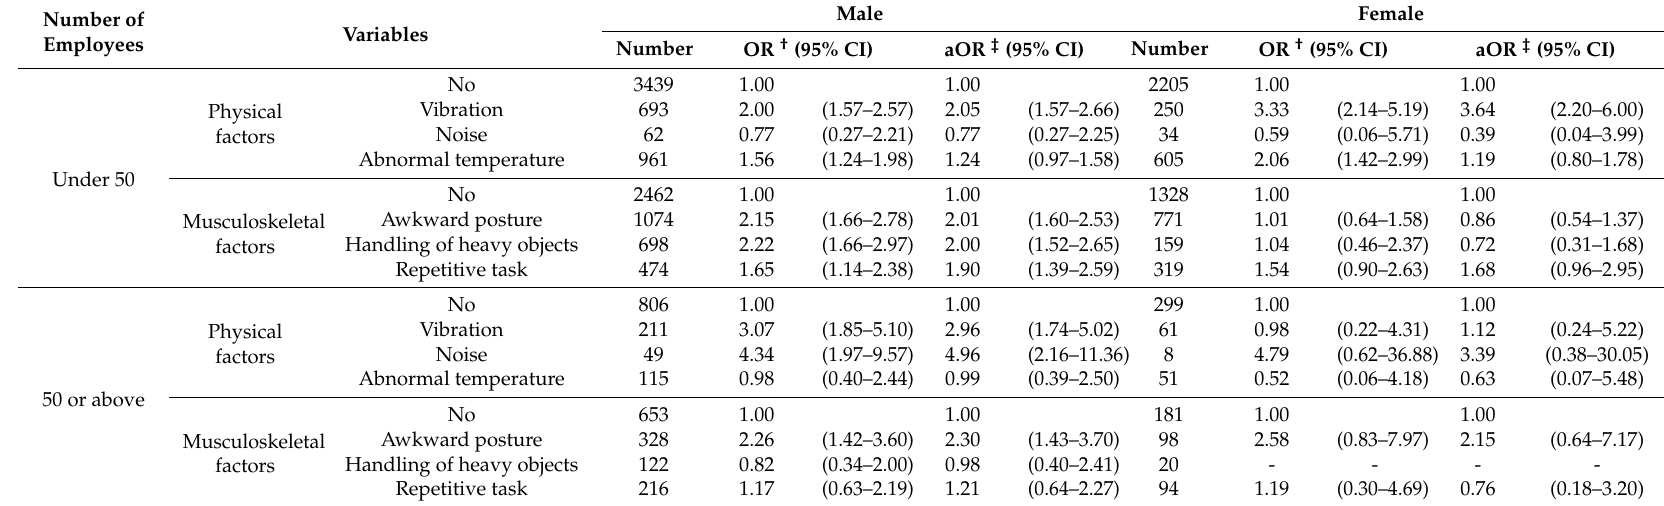
Table 4. OR and aOR for occupational injuries and accidents based on physical and musculoskeletal factors according to gender, and company